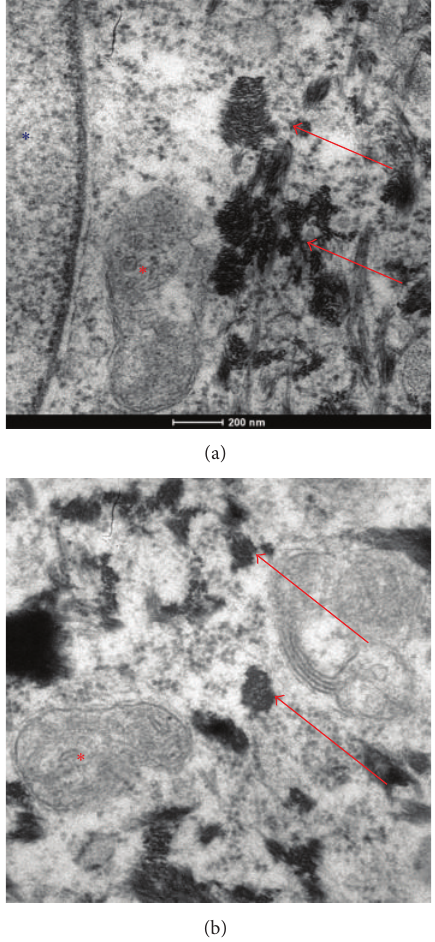
Figure 6: TEM images of AgNps (red arrows) in cytoplasmatic space of fibroblast present in a healed skin sample treated with AgNps based Medical devices. AgNP are closed to the mitochondria (red ∗ ); and not inside the mitochondria and inside the nuclei (indicated by blue ∗ ).